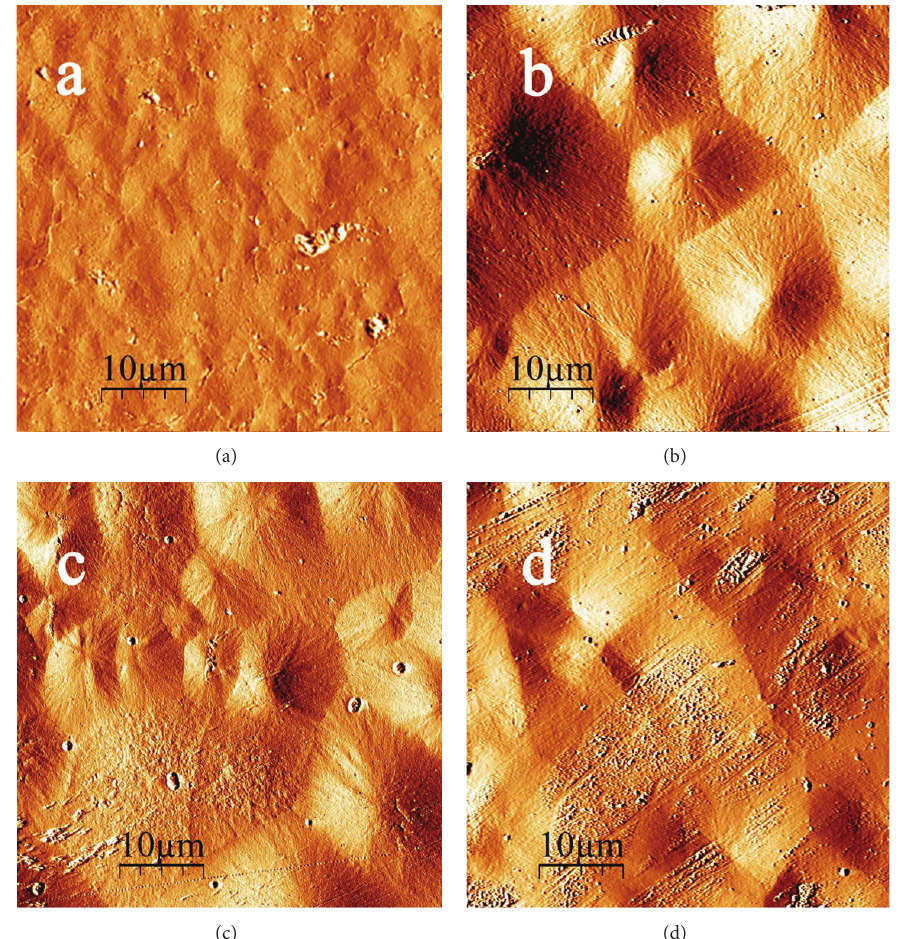
Figure 1: AFM images of (a) PP-g-MAH, (b) PP/PP-g-MAH, (c) 1pph CF/PP, and (d) 1pph CF PP/PP-g-MAH.